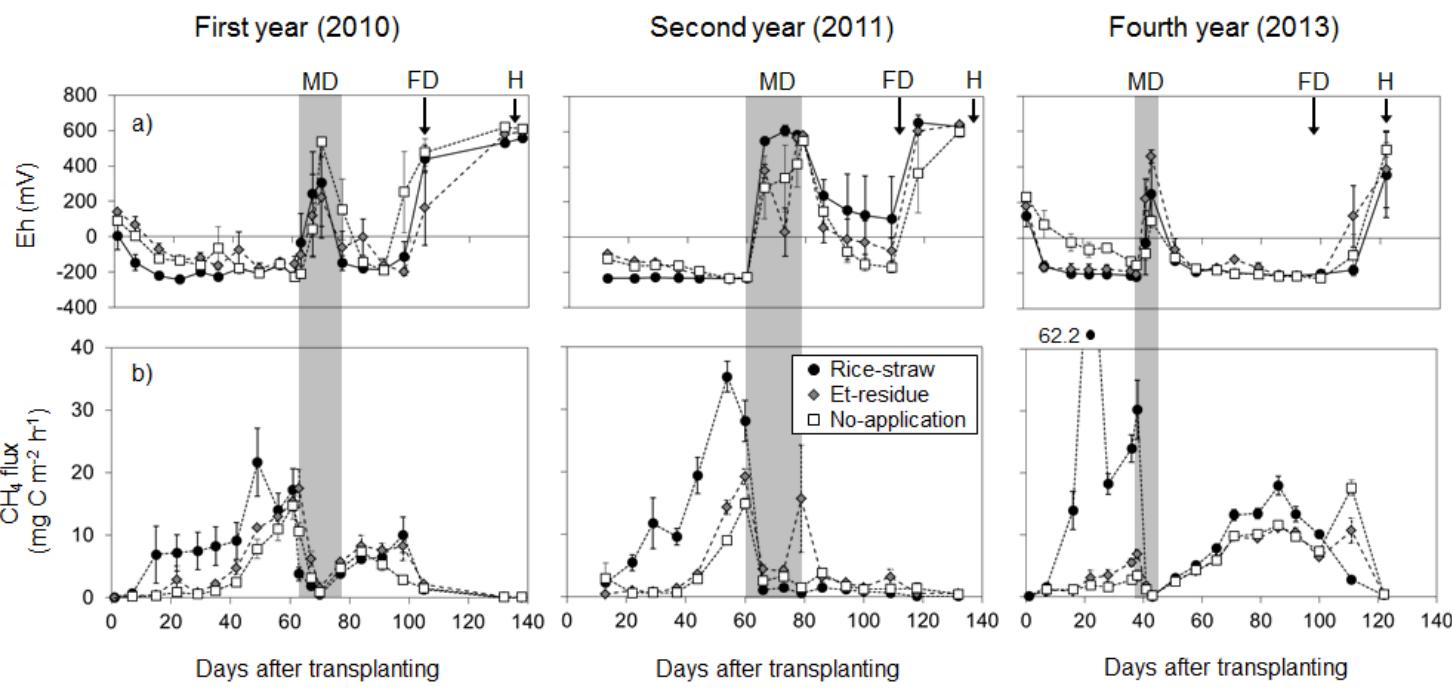
Figure 5. Time course of soil Eh at 5 cm depth ( a ) and CH 4 flux ( b ) during the rice growing period. Bars indicate standard errors. FD, final drainage; H, Harvesting; MD, mid ‐ season drainage.